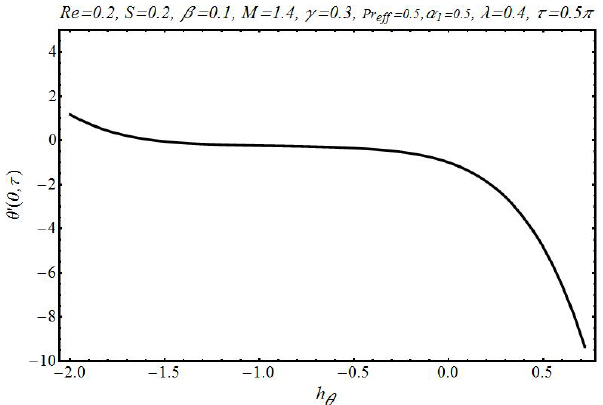
Figure 3: (cid:125) -curve for θ ′ (0, τ ) at 6 th order of approximation.